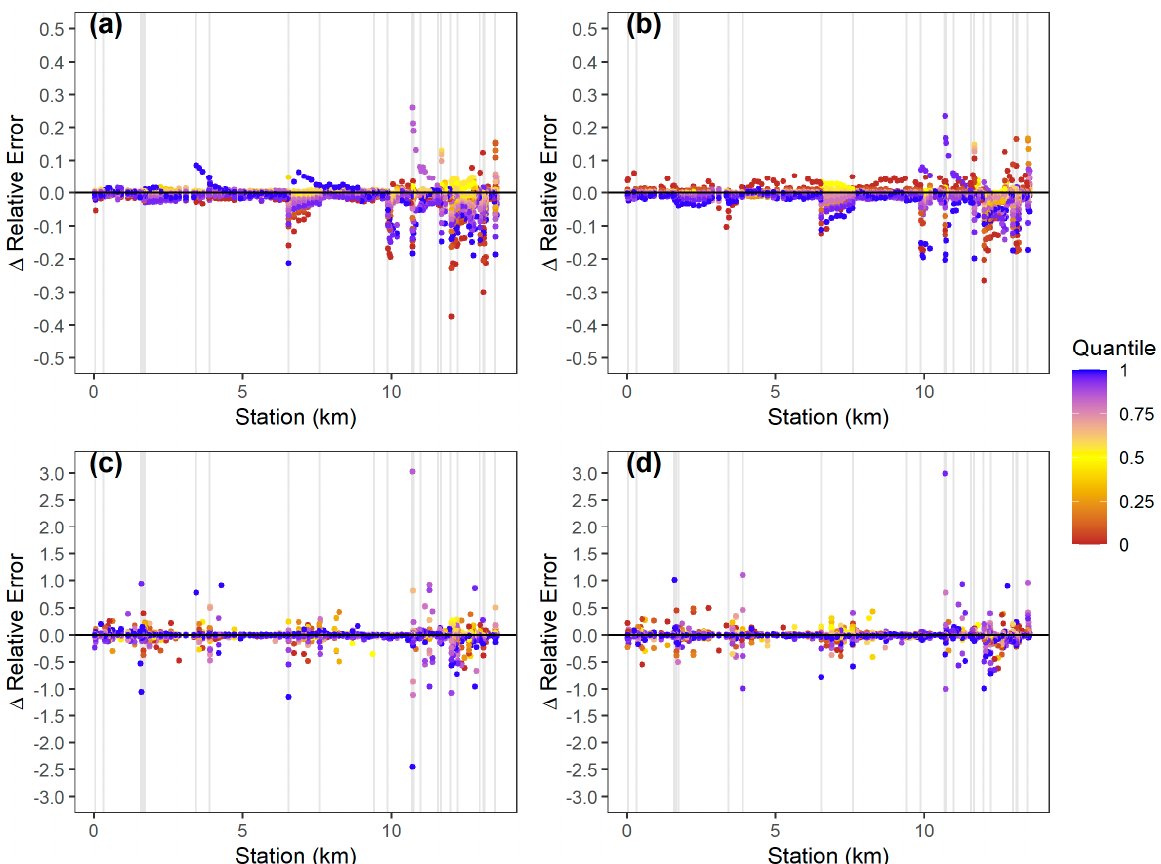
Figure 8. Difference in the absolute value of relative error between simulations of SUB with structures and without structures for the ( a ) 1% AEP depth, ( b ) 2% AEP depth, ( c ) 1% AEP top width, and ( d ) 2% AEP top width. Table 3. General trends between top width errors in SUB and physical and hydraulic metrics. (+) indicates a positive trend, ( − ) indicates a negative trend, and (0) indicates no apparent trend. Predictor